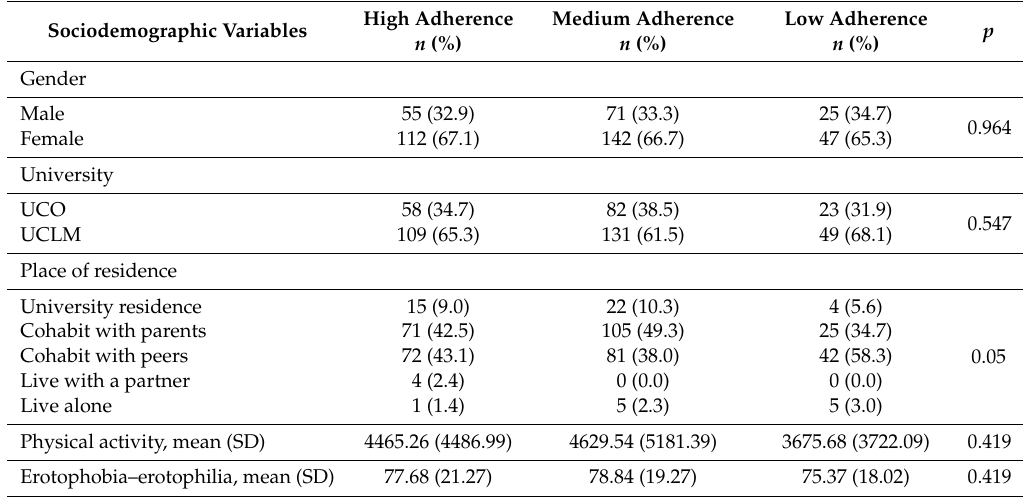
Table 1. Sociodemographic variables and adherence to the Mediterranean diet (KIDMED).